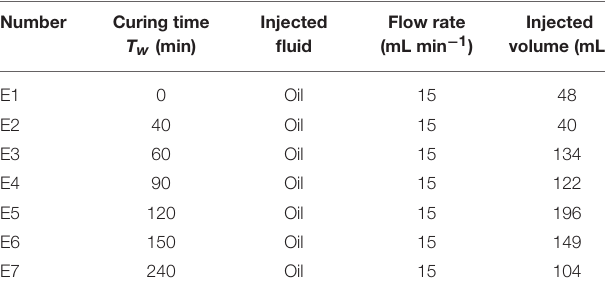
TABLE 1 | List of experiments and experimental